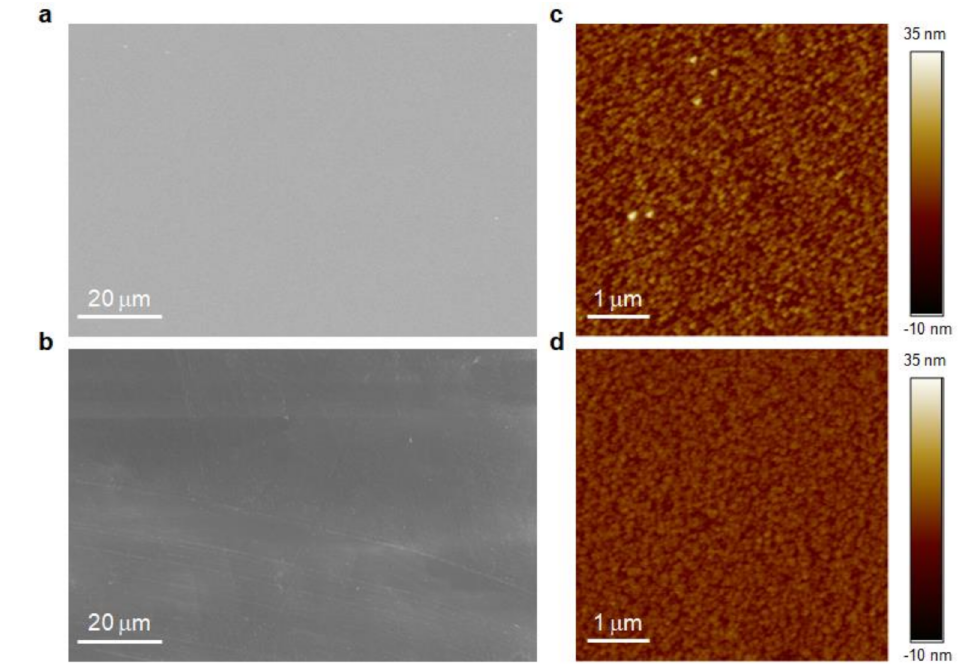
Figure 4. ( a ) SEM micrographs for diamond surface after etching in SF 6 (30 sccm, 10 min, ICP power = 500 W); ( b ) SEM micrographs for diamond surface after etching in O 2 (50 sccm, 2.5 min, ICP power = 800 W)—O 2 /CF 4 (40/10 sccm, 0.5 min, ICP power = 200 W); ( c ) AFM surface topography